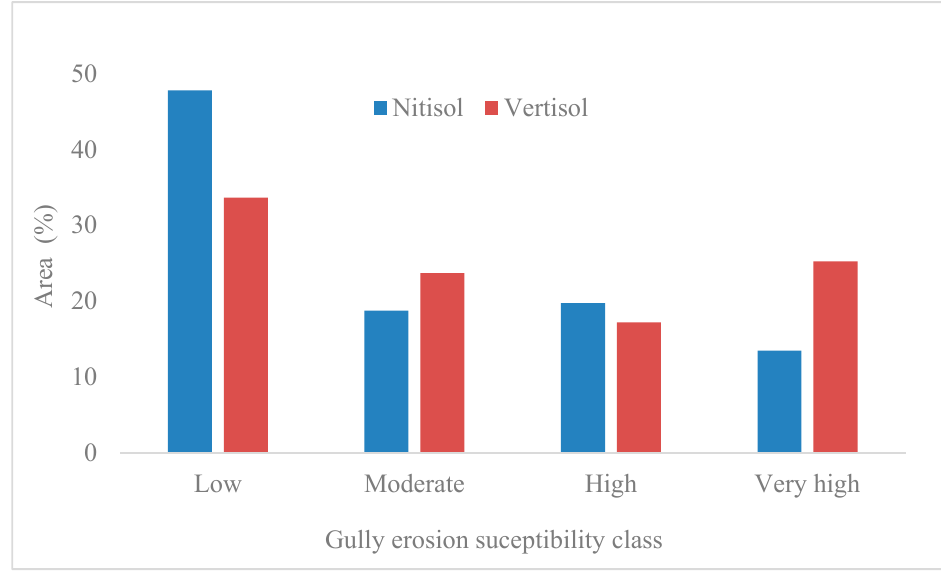
Figure 6. Gully erosion susceptibility in Nitisol and Vertisol soils.